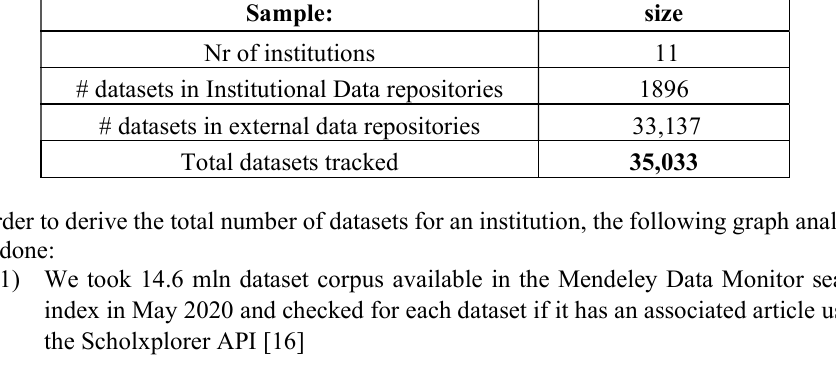
Table 2. Sample size – counts from March 2020